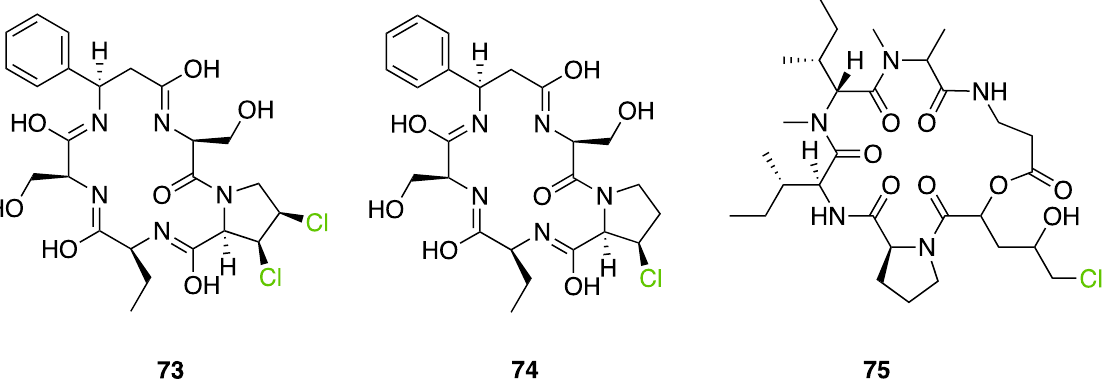
Figure 31. Example of halogenated non ribosomal peptides found in this specific cluster 7, cyclochlorotine ( 73 ) and cyclochlorotine B ( 74 ) from Penicillium islandicum , destruxin-A4-cyclohydrin ( 75 ) from unknown fungi.